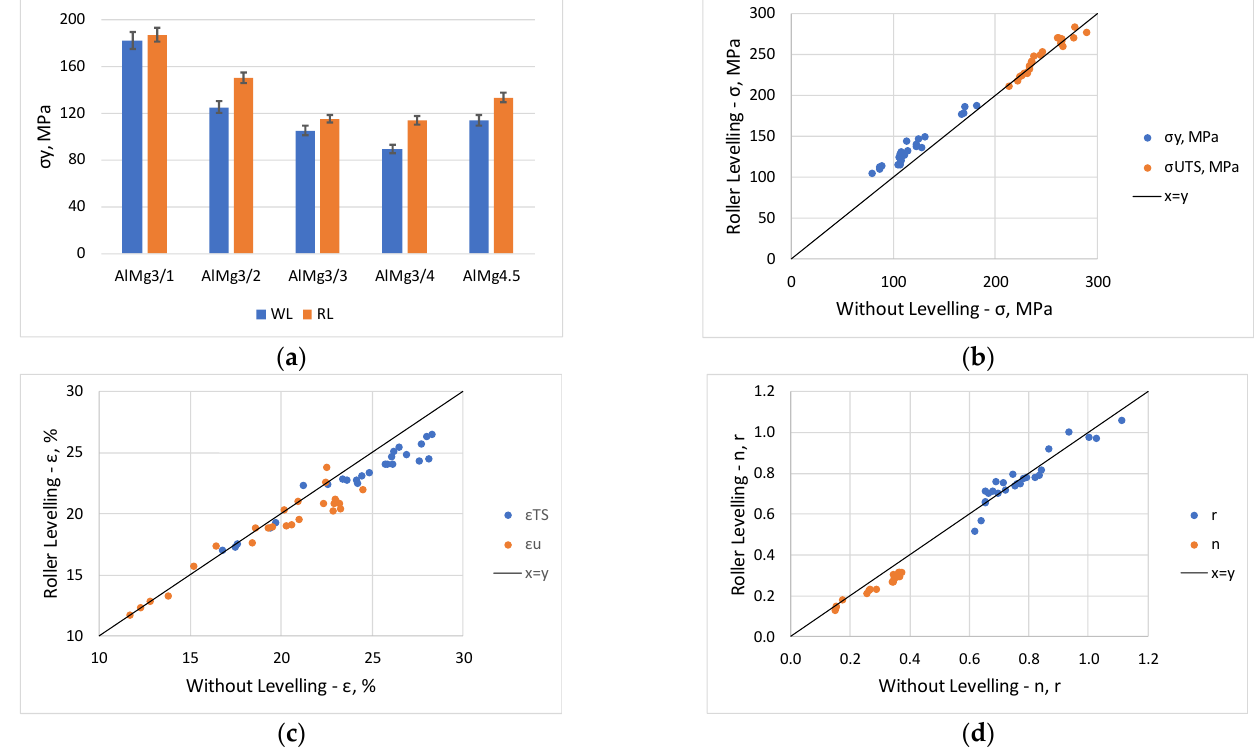
Figure 7. Comparison of tensile test results ( a ) yield strength comparison of AlMg3 and AlMg4.5; ( b – d ) further comparison of tensile test parameters.